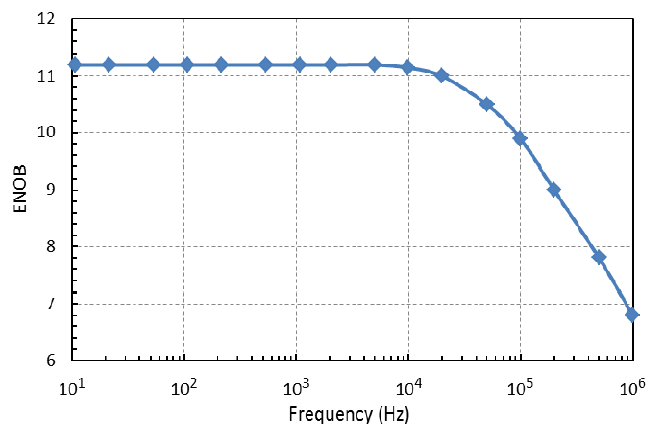
Figure 6. ENOB results for SimpleDAQ